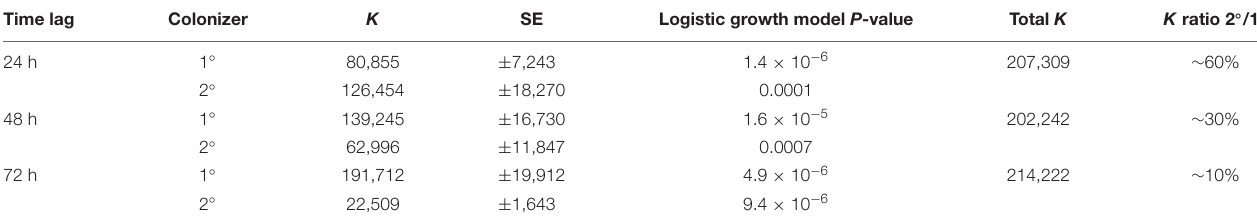
TABLE 1 | Carrying capacity ( K ) for consecutive Curvibacter colonization in the host habitat Hydra fitted to a logistic growth model. Time lag Colonizer K